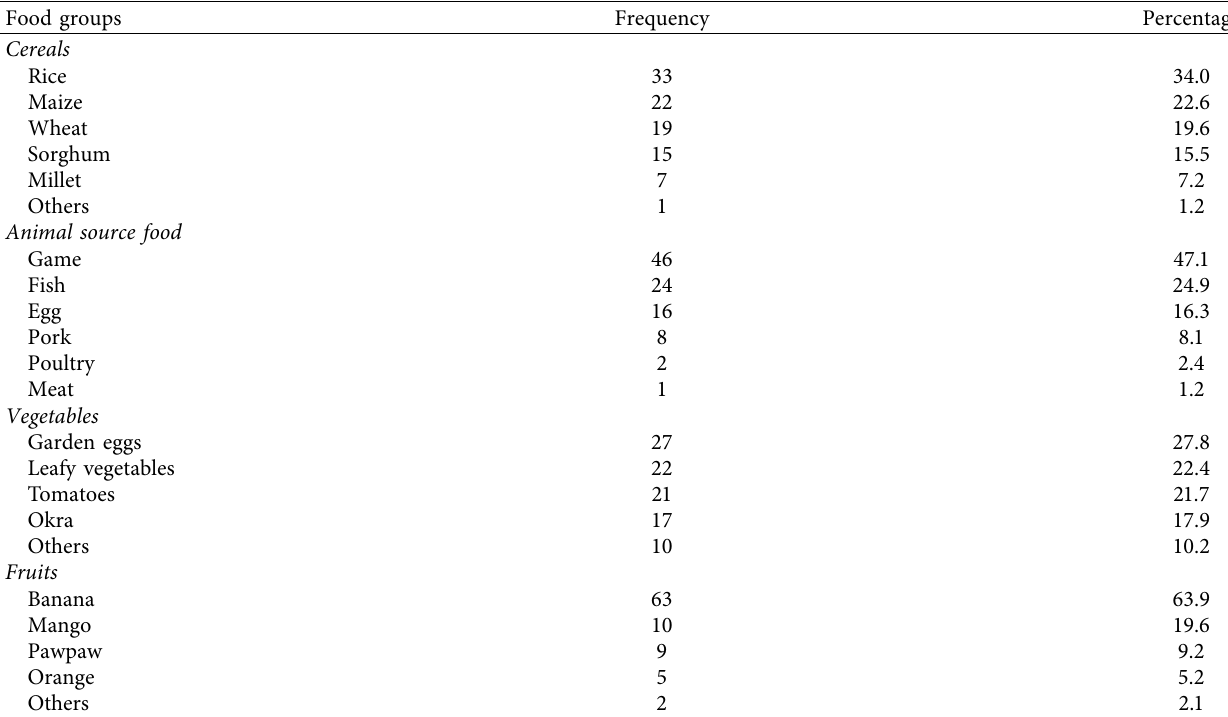
Table 2: Dietary habits of